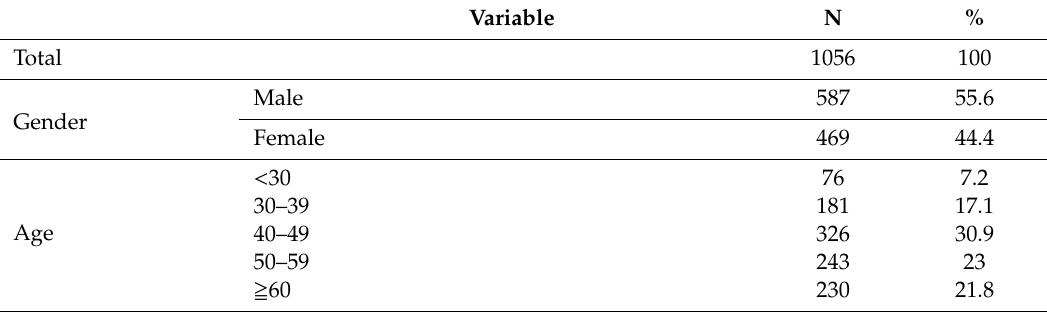
Table 1. Demographic characteristics of